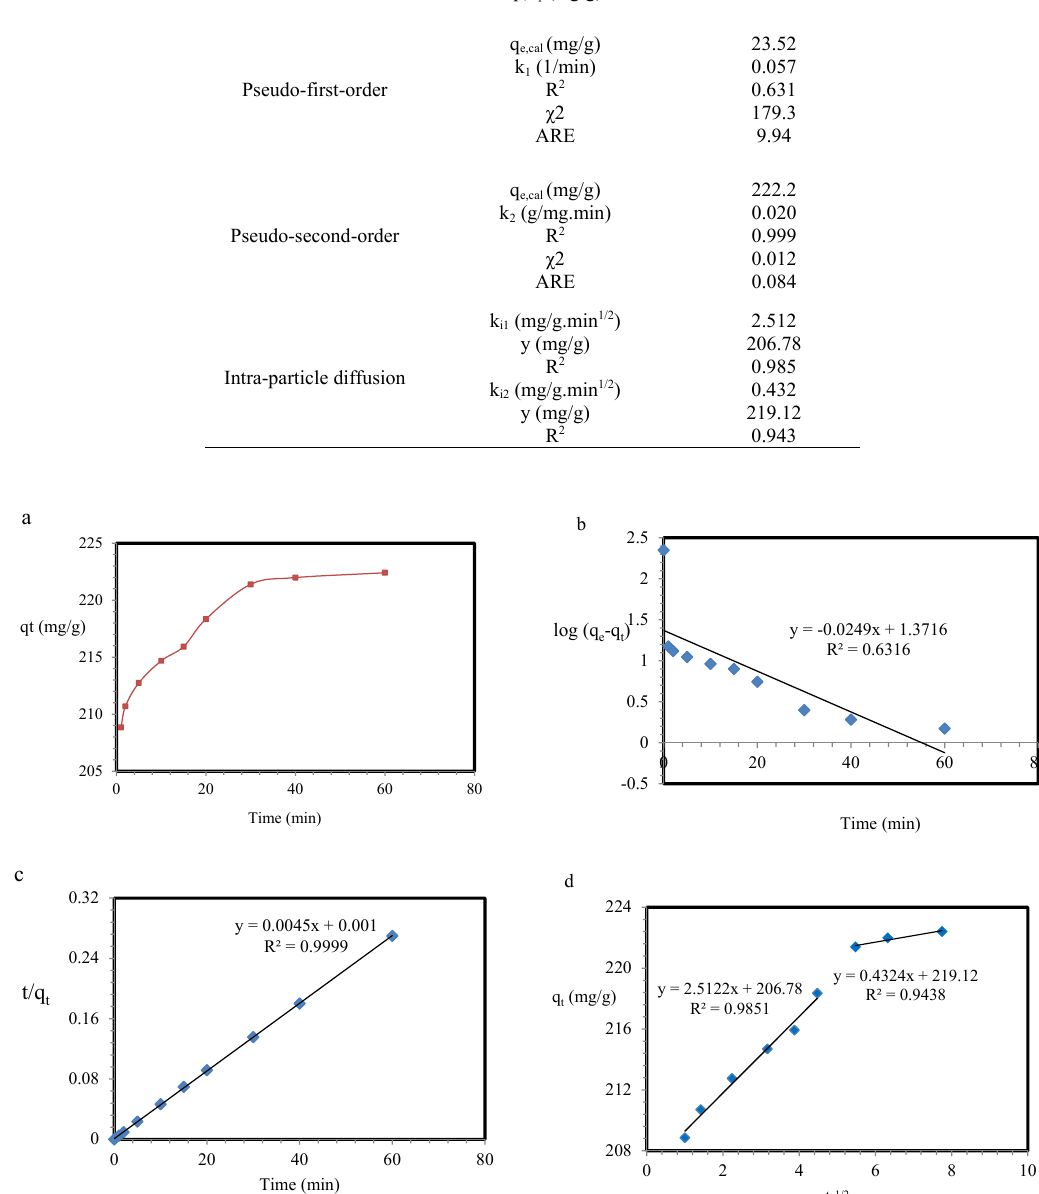
O /AC nanocomposite (b) Plot of pseudo-first-order kinetic, (c) plot Fig. 6. (a) Effect of contact time on the removal of MB onto Fe 3 4 of pseudo-second-order kinetic and (d) plot of intra-particle diffusion model. Fig. 6 (a) Effect of contact time on the removal of MB onto Fe3O4/AC nanocomposite (b) Plot of pseudo-first- order kinetic, (c) plot of pseudo-second-order kinetic and (d) plot of intra-particle diffusion